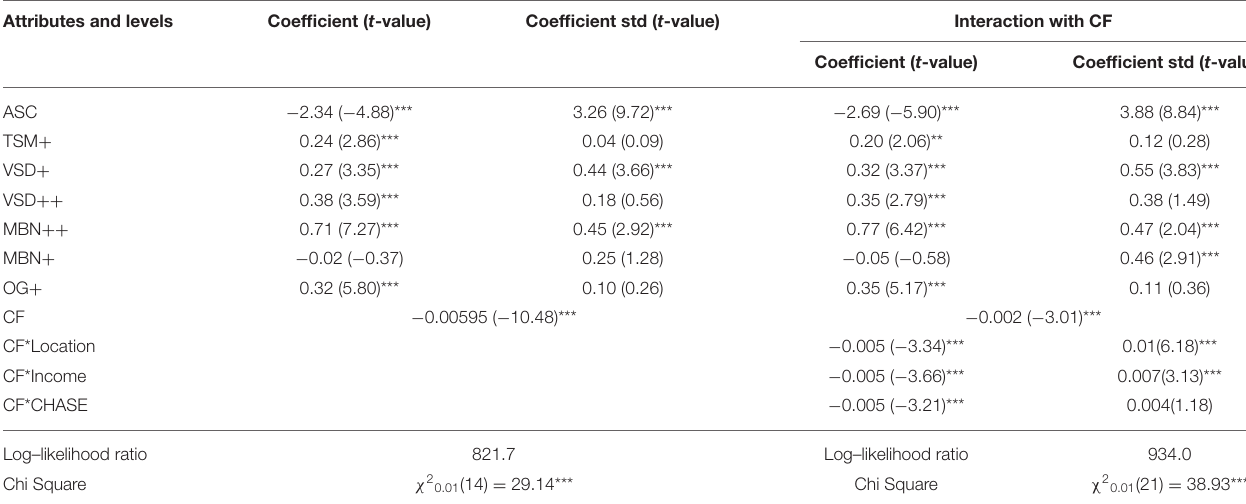
TABLE 4 | Results of the random parameter logit model with interactions. Attributes and